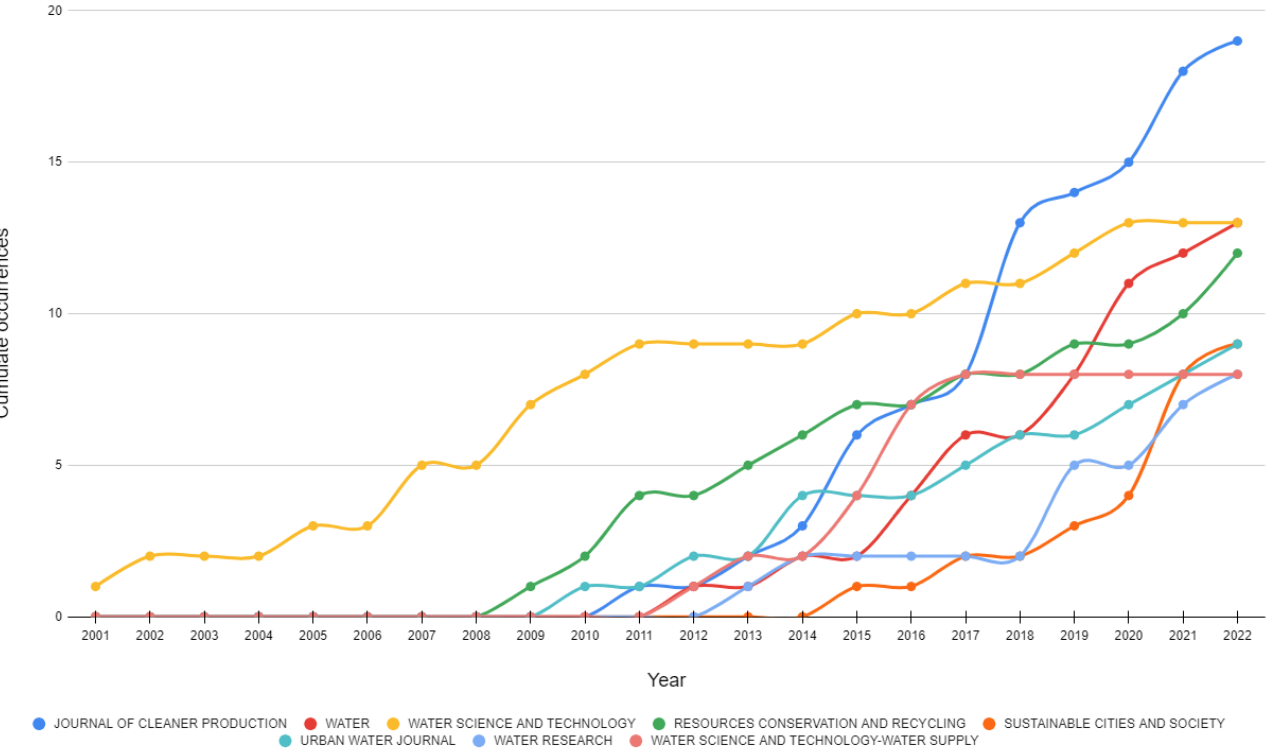
Figure 12. Publications in greywater recycling domain in the top eight journals. Table 11. The most productive journals in greywater recycling domain.